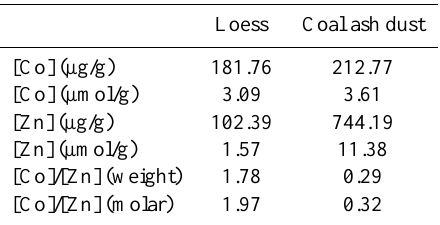
Table 2. Elemental composition in Co and Zn of the natural and anthropogenic dust samples as determined by ICP-AES (µg/g and µmol/g) and ratio [Co]/[Zn].